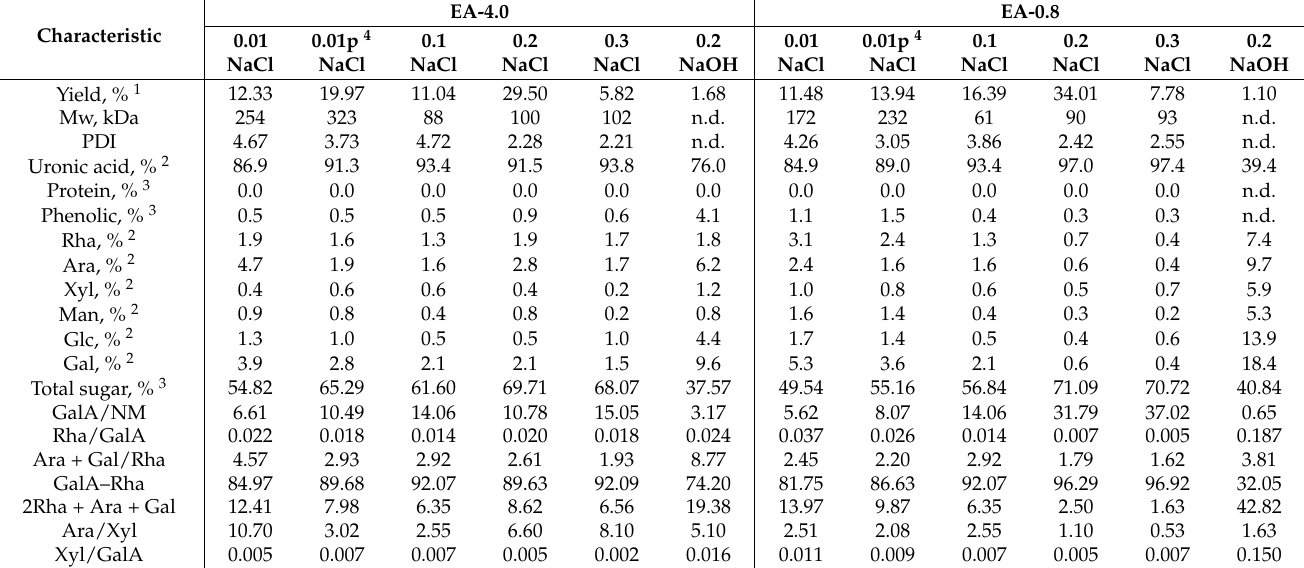
Table 2. Chemical characteristics of the polysaccharide fractions obtained during fractionation of EA-4.0 and EA-0.8 on DEAE-cellulose column (OH −